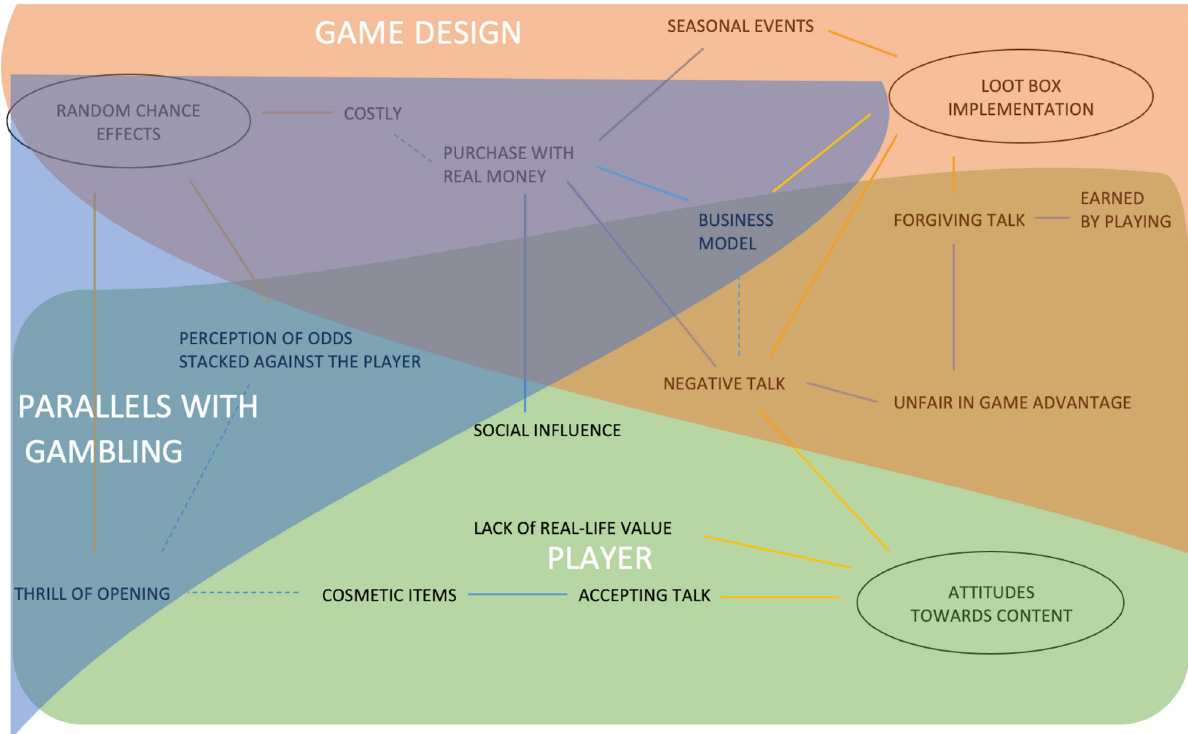
Fig 3. Represents the adapted thematic map from RQ1. Game design themes are grouped in orange, parallels with gambling themes are highlighted in blue and player themes are highlighted in green for RQ2.